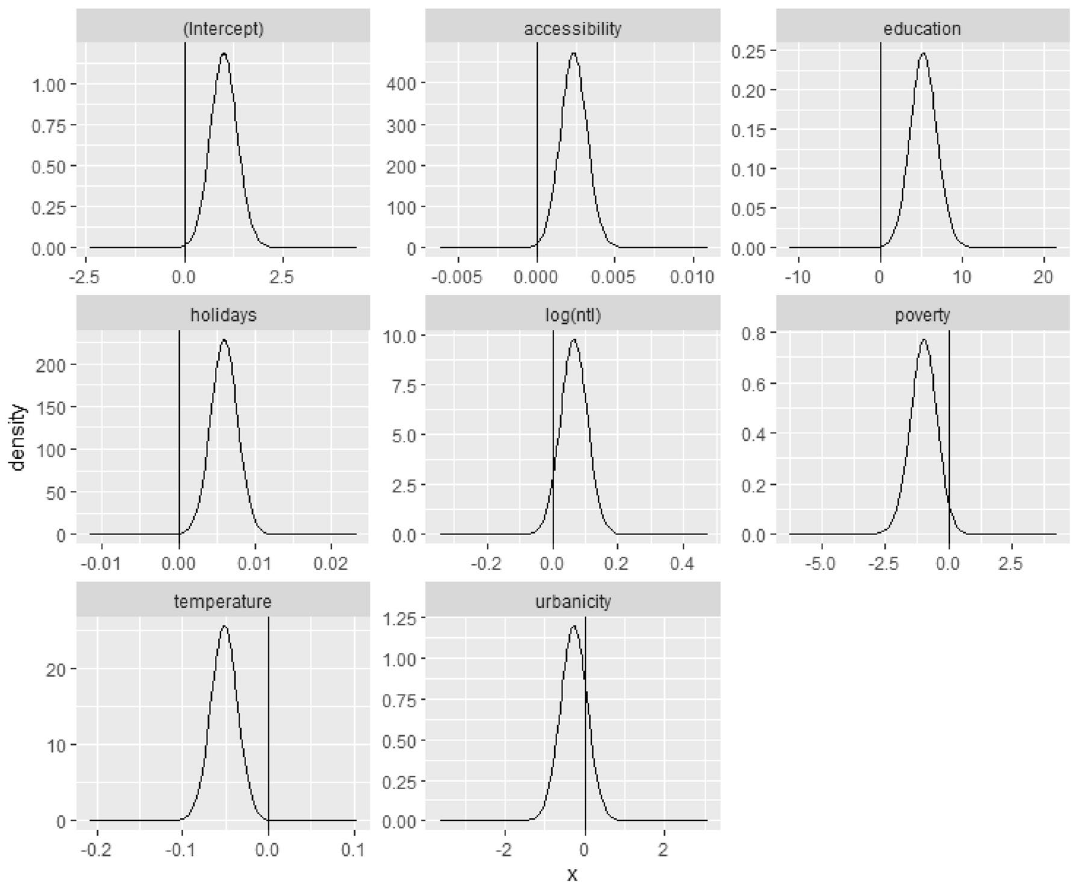
Figure 4. Posterior densities of modelled fixed effects. Parameters with peak densities further away from zero indicate a stronger influence on the model. NTL night-time